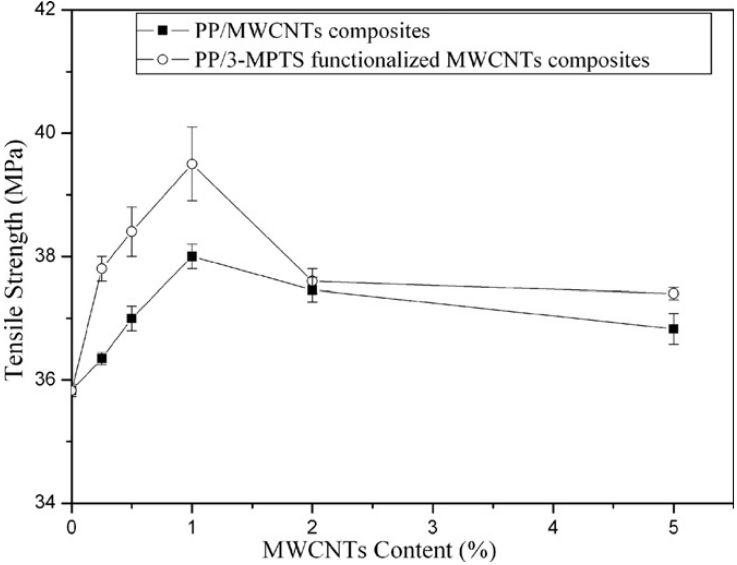
Figure 40. Effect of raw MWCNTs and 3-MPTS functionalized MWCNTs content on tensile strength of the PP composite. Reproduced with permission from ref.